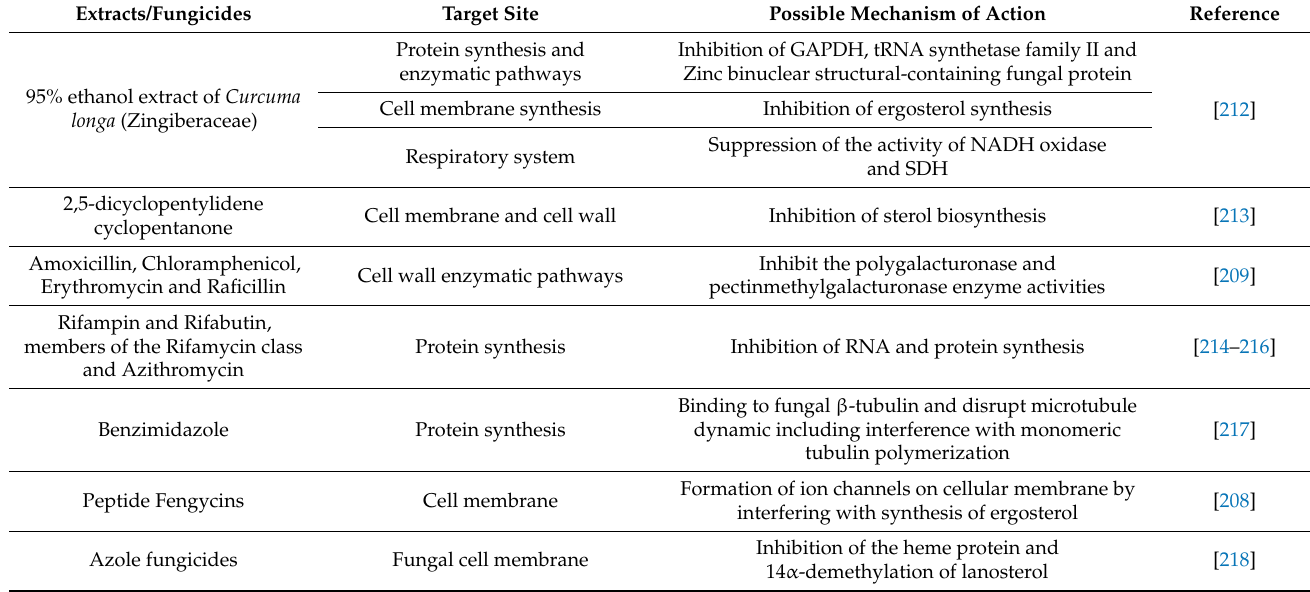
Table 5. Possible mechanisms of action of pesticides against Fusarium phytopathogenic species.